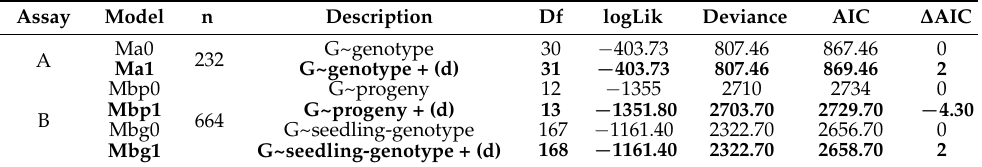
Table 2. Results of models (GLMs and LMMs) describing the variation of mean daily lesion growth (G; mm/day) with progeny, seedling-genotype, and diameter (d; mm) in the in vitro assay. Random factors of LMMs are shown in brackets. n: number of observations used for model fitting. Selected model in bold.